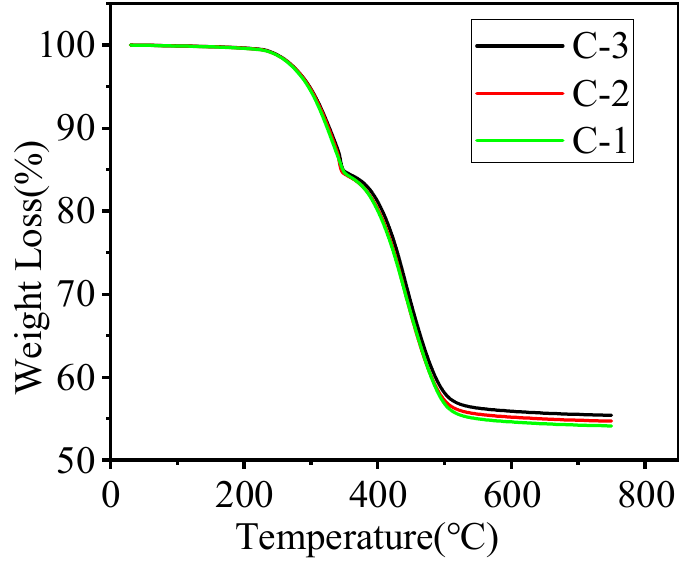
Figure 13. TG curve of 110 kV samples from factory C.